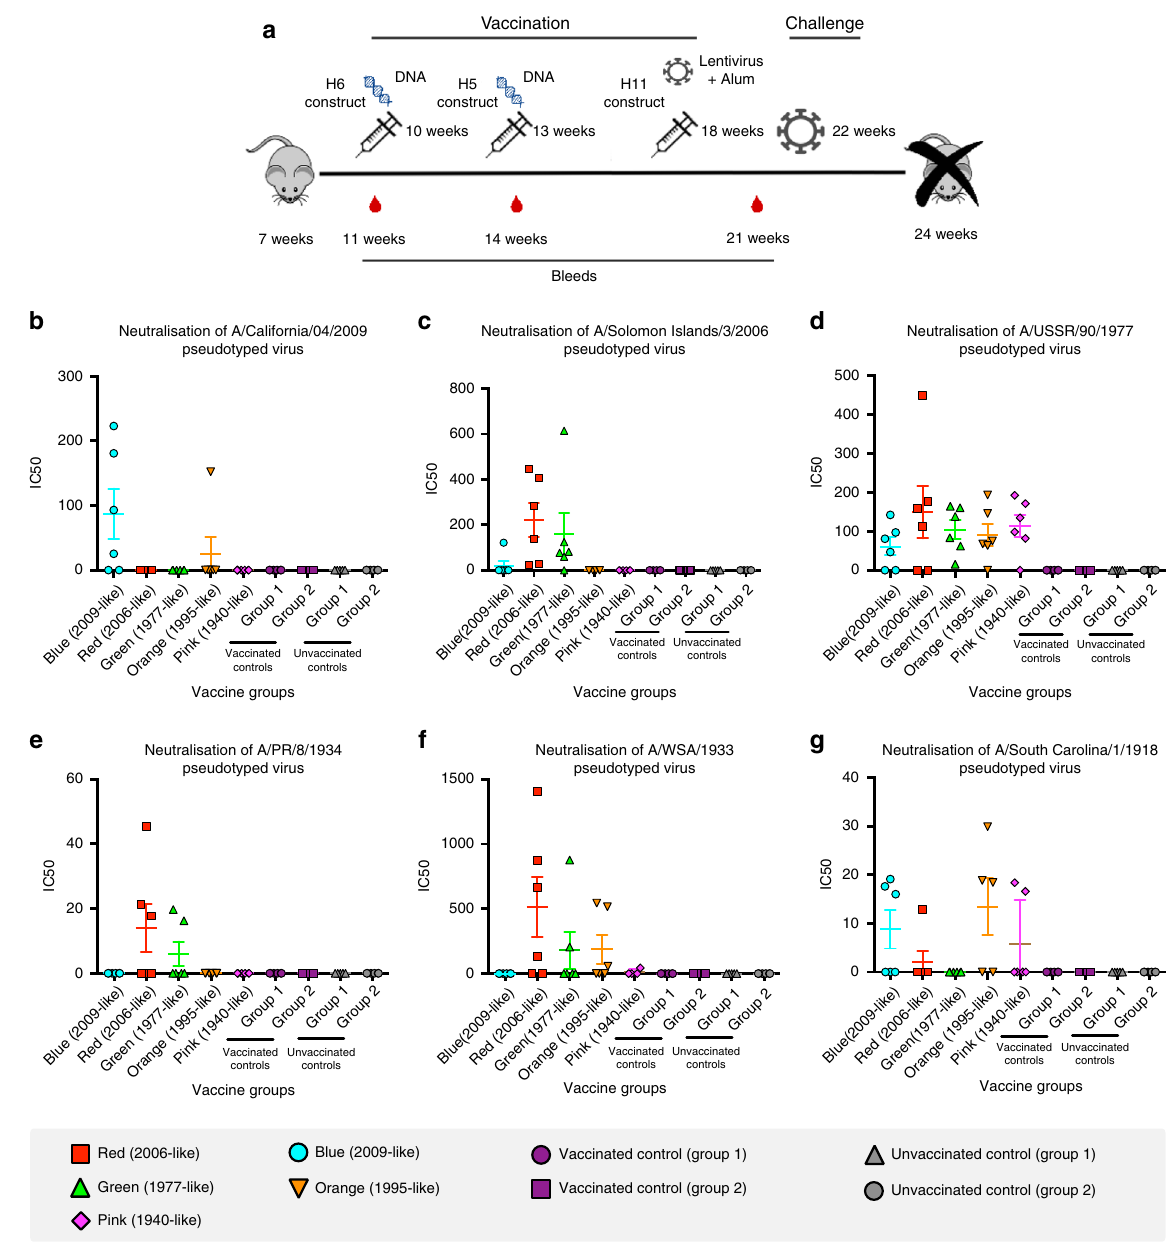
Fig. 4 Sequential vaccination using chimeric HA constructs. a Five groups of mice were sequentially vaccinated with 2009-like (blue), 2006-like (red), 1995-like (orange), 1977-like (green) and 1940-like (pink) epitope sequences substituted into H6, H5 and H11 HAs (see Supplementary Table 1). Two further control groups were sequentially vaccinated with H6, H5 and H11 constructs without any sequence substituted into the HAs (vaccinated controls). Further two groups were mock vaccinated (unvaccinated controls). b – g Pseudotype microneutralisation assays using 0.5 μ l of sera from the bleed at 21 weeks. Error bars are mean ± s.e.m. n = 6 for experimental groups and control groups. The values provided are an average of two replicates